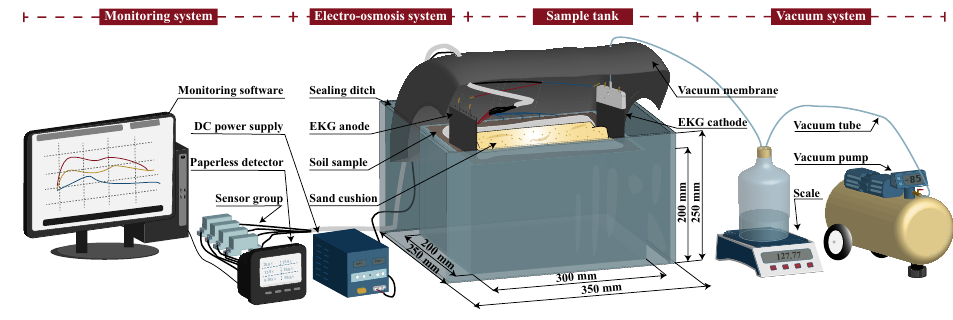
Figure 2. Diagrammatic sketch of vacuum electro-osmosis test